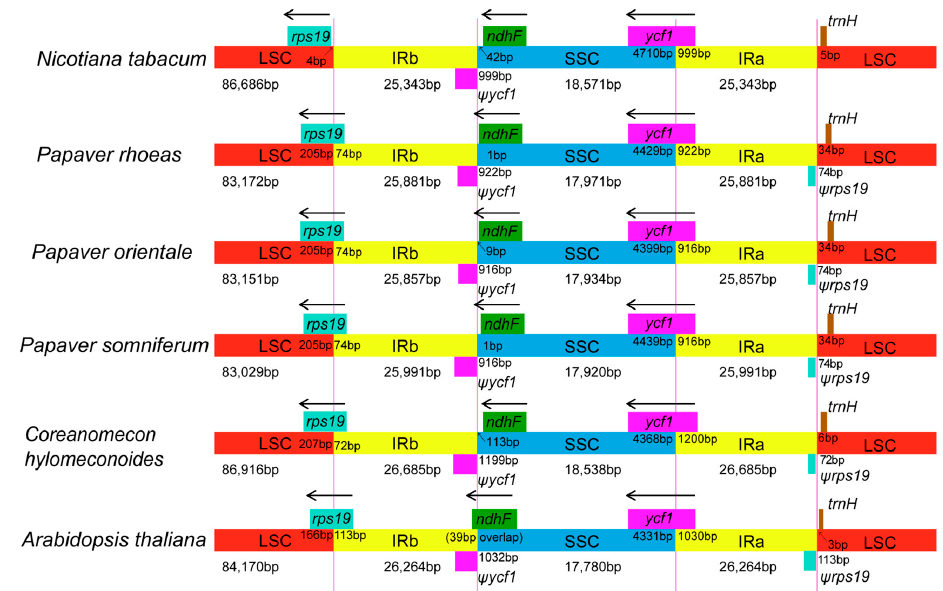
Figure 5. The borders of LSC, SSC and IR regions among six chloroplast genomes. The number above the gene features means the distance between the ends of genes and the borders sites. The IRb/SSC border extended into the ycf1 genes to create various lengths of ycf1 pseudogenes among the six chloroplast genomes. The IRb/LSC border extended into the rps19 genes to create various lengths of rps19 pseudogenes among the five chloroplast genomes. The arrows indicated the orientation (5’ → 3’) of the ycf1 , rps19 , and ndhF genes. These features are not to scale.